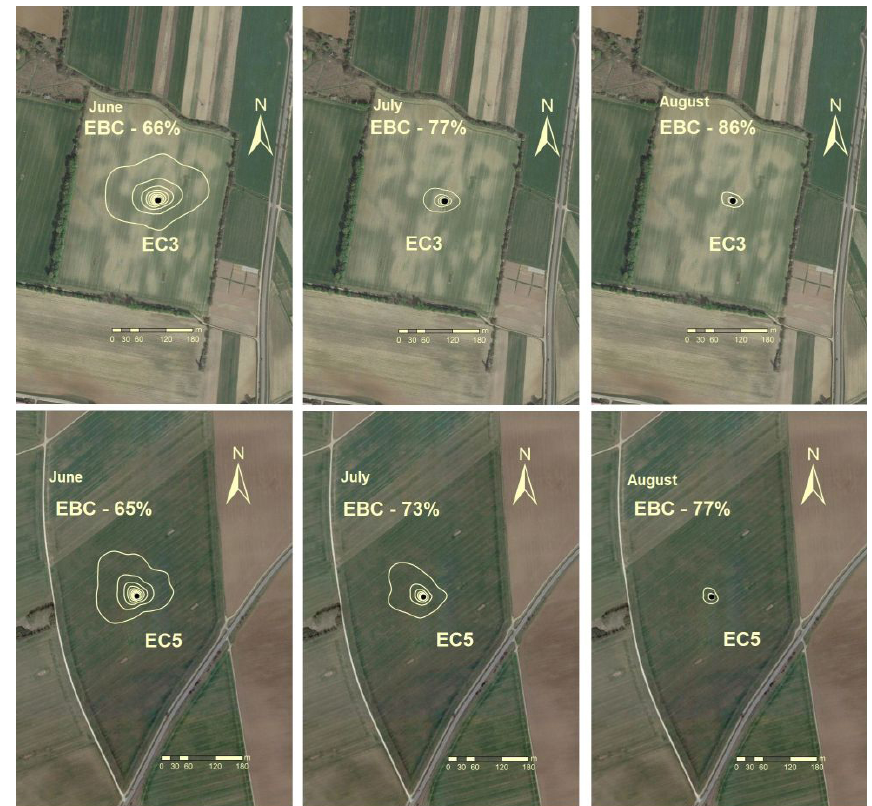
Figure 11. Footprint area of EC3 and EC5 in selected months of 2015 and the corresponding energy balance closure (EBC). Black points represent positions of EC stations. Yellow lines indicate relative areal contributions to total flux in 10% steps, where the outmost yellow line indicates the area from which 90% of measured fluxes originated. The satellite image was taken from Google Earth (images from 31 March 2017 and 30 March 2014 for EC3 and EC5,